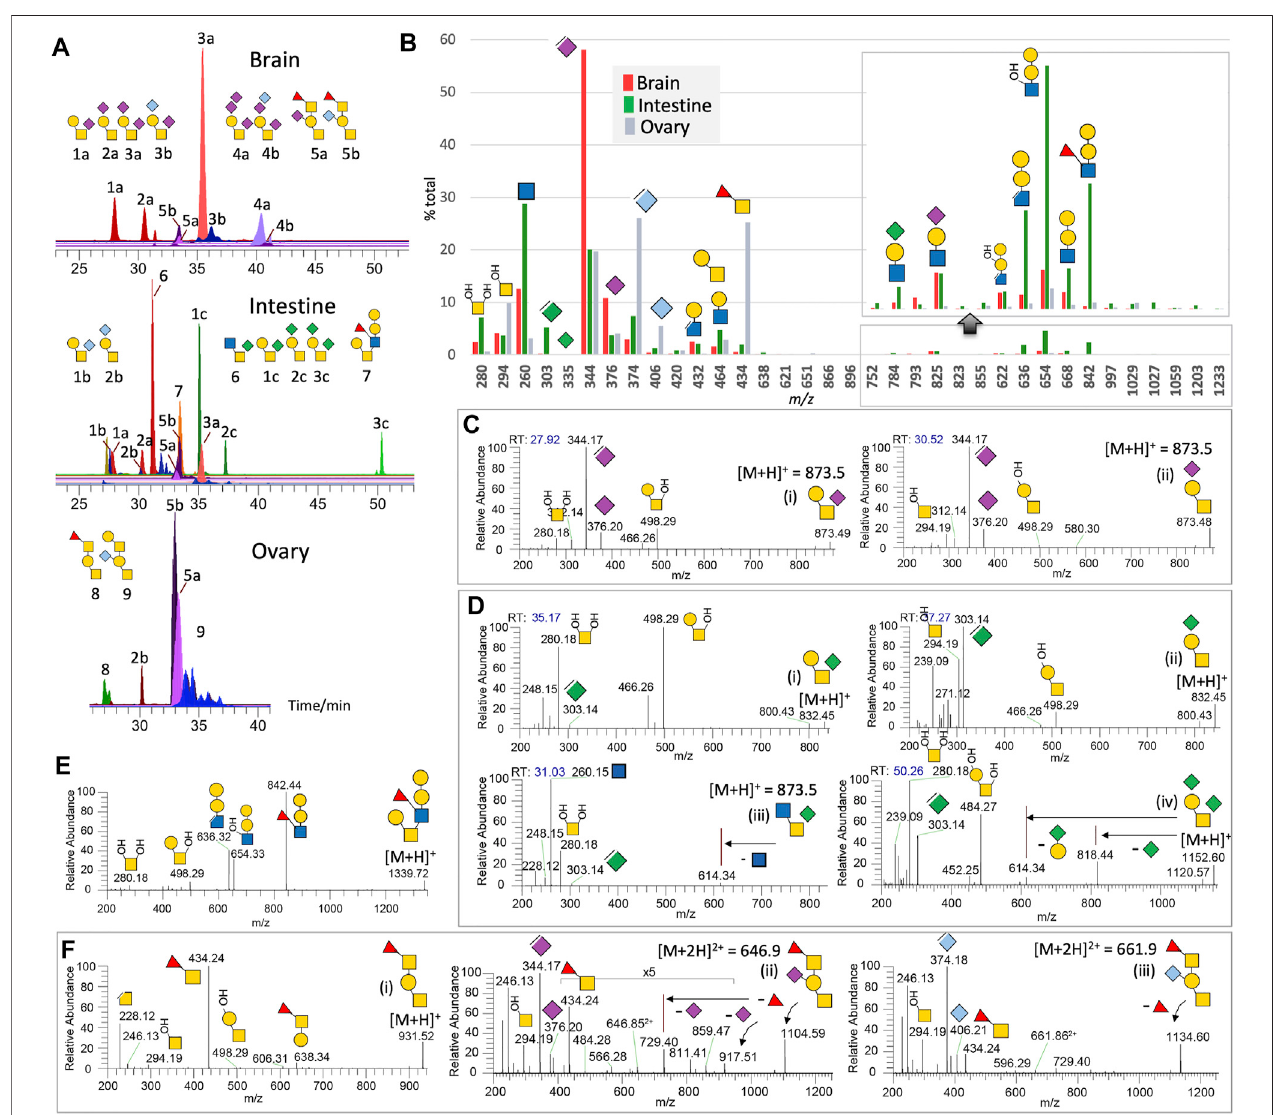
FIGURE 2 | Non-sulfated O-glycans of adult zebra fi sh. LC-MS/MS analysis of the non-sulfated O-glycans unambiguously identi fi ed at least 9 distinct major structures,someofwhichadditionallycomprisedifferentNeuAc,NeuGc,orKDN-sialylatedversions,withbrain-,intestine-,andovary-speci fi cdistributionpatternshown by their respective overlaid XIC plots normalized to the most abundant structure found in each of the three organs (A) . Summed intensity for each of the detected diagnostic MS 2 ions normalized to their total provides an overall assessment of the relative abundance and organ-speci fi c distribution of the three sialic acids and variousglycotopes (B) .NotethattheabundanceofKDNisunderrepresentedbytheintensityofitsoxoniumionsat m/z 303/335relativetothoseofNeuAcandNeuGcat m/z 344/376and374/406. m/z 335forKDN + washardlydetectable.Aportionofthebarchartwasmagni fi edtoshowonlytheGal-Gal-( ± Fuc)GlcNAcglycotopede fi ned by ions at m/z 842, 668, 654, and 636, and not its additionally sialylated version, and wasexpressed at a signi fi cant level in the intestine alone. The origins of most of the annotated diagnostic MS 2 ions in (B) can be found in representative sets of MS 2 spectra shown here for the NeuAc-monosialylated core 1 (C) , KDN-sialylated cores 1 and 3 (D) , core 2 (E) , and core 1 structures carrying the unique Fuc-GalNAc glycotope (F) . Assignment of terminal the Fuc-3GalNAc glycotope extending from ± sialylated core 1 structure is based on previous work on the adult zebra fi sh O-glycans (Yamakawa et al.,